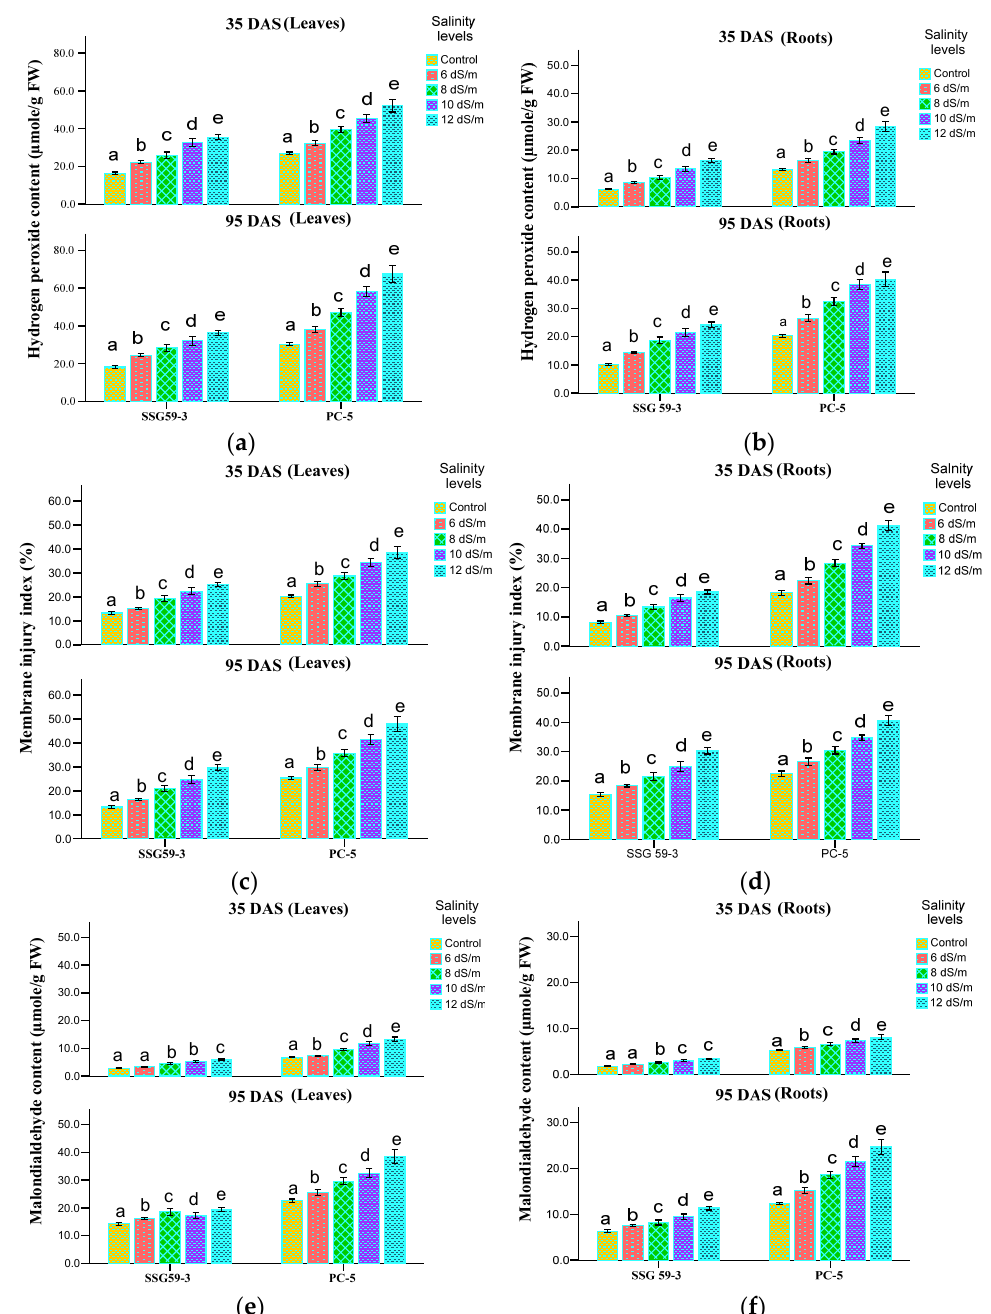
Figure 11. Effect of salt stress on hydrogen peroxide (H 2 O 2 , ( a , b )), membrane injury index (MII, ( c , d )), and malondialdehyde (MDA, ( e , f )) of sorghum genotypes at 35 and 95 DAS. Post hoc compar- isons of the means were performed using Tukey’s HSD test at p < 0.05; different letters ( a–e ) indicate significant differences among treatments within each